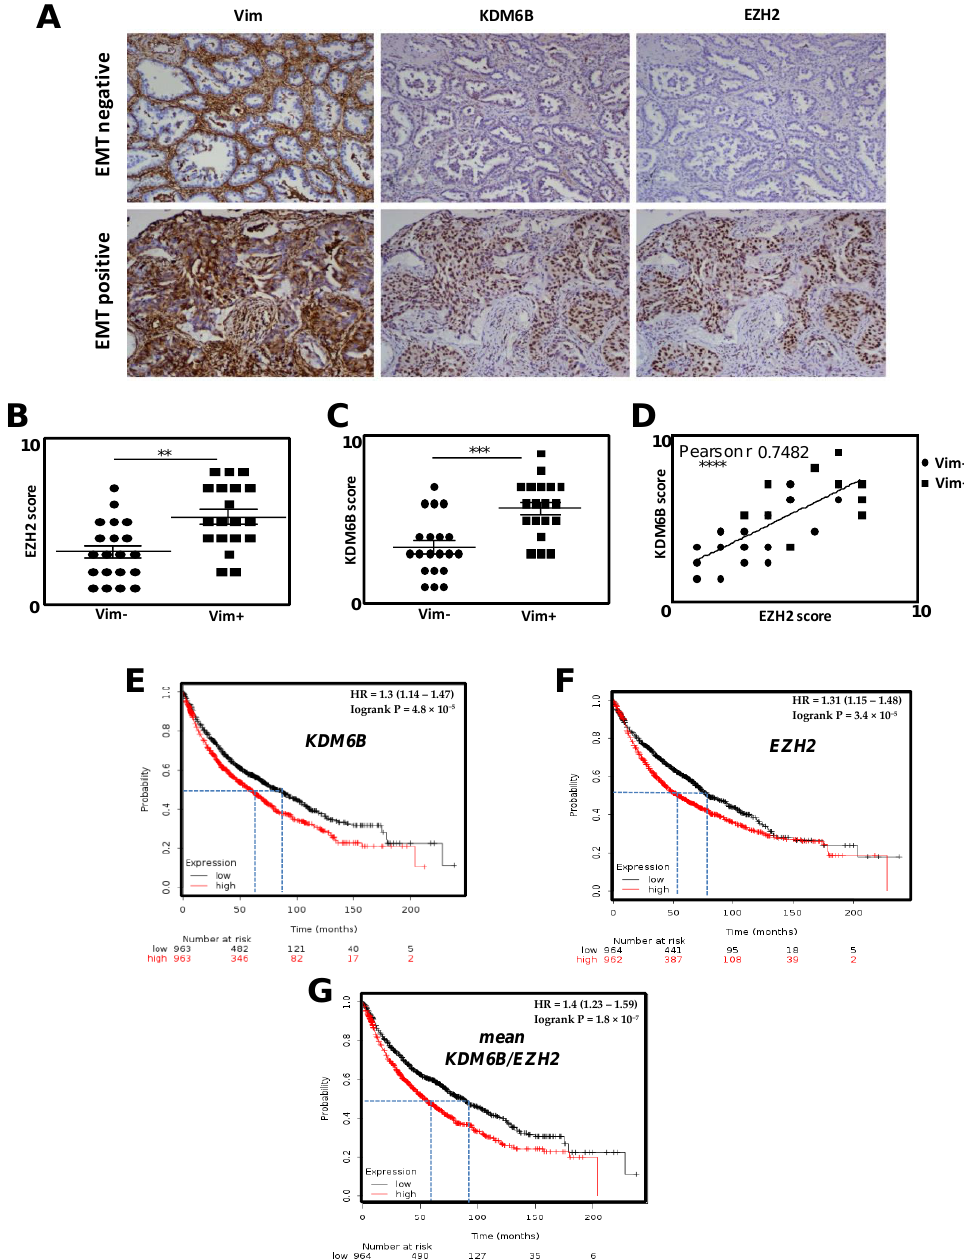
Figure 1. EZH2 and KDM6B expressions are correlated with EMT in NSCLC. ( A ) Representative IHC stainings of Vimentin (Vim, high score: EMT positive / low score: EMT negative), KDM6B, and EZH2 in 30 NSCLC (magnification × 100). ( B ) Quantification of the IHC EZH2 score regarding the EMT status. ( C ) Quantification of the IHC KDM6B score regarding the EMT status. ( D ) The correlation between EZH2 and KDM6B scores in NSCLC. ( E ) The KM-plotter for KDM6B expression showing the survival curves of patients with lung cancer classified in high expression (red) or low expression (black) groups. ( F ) The KM-plotter for EZH2 expression. (G ) The KM-plotter for the mean of EZH2 / KDM6B expression. ** = 0.005 < p < 0.01; *** = 0.001 < p < 0.005; **** = p <